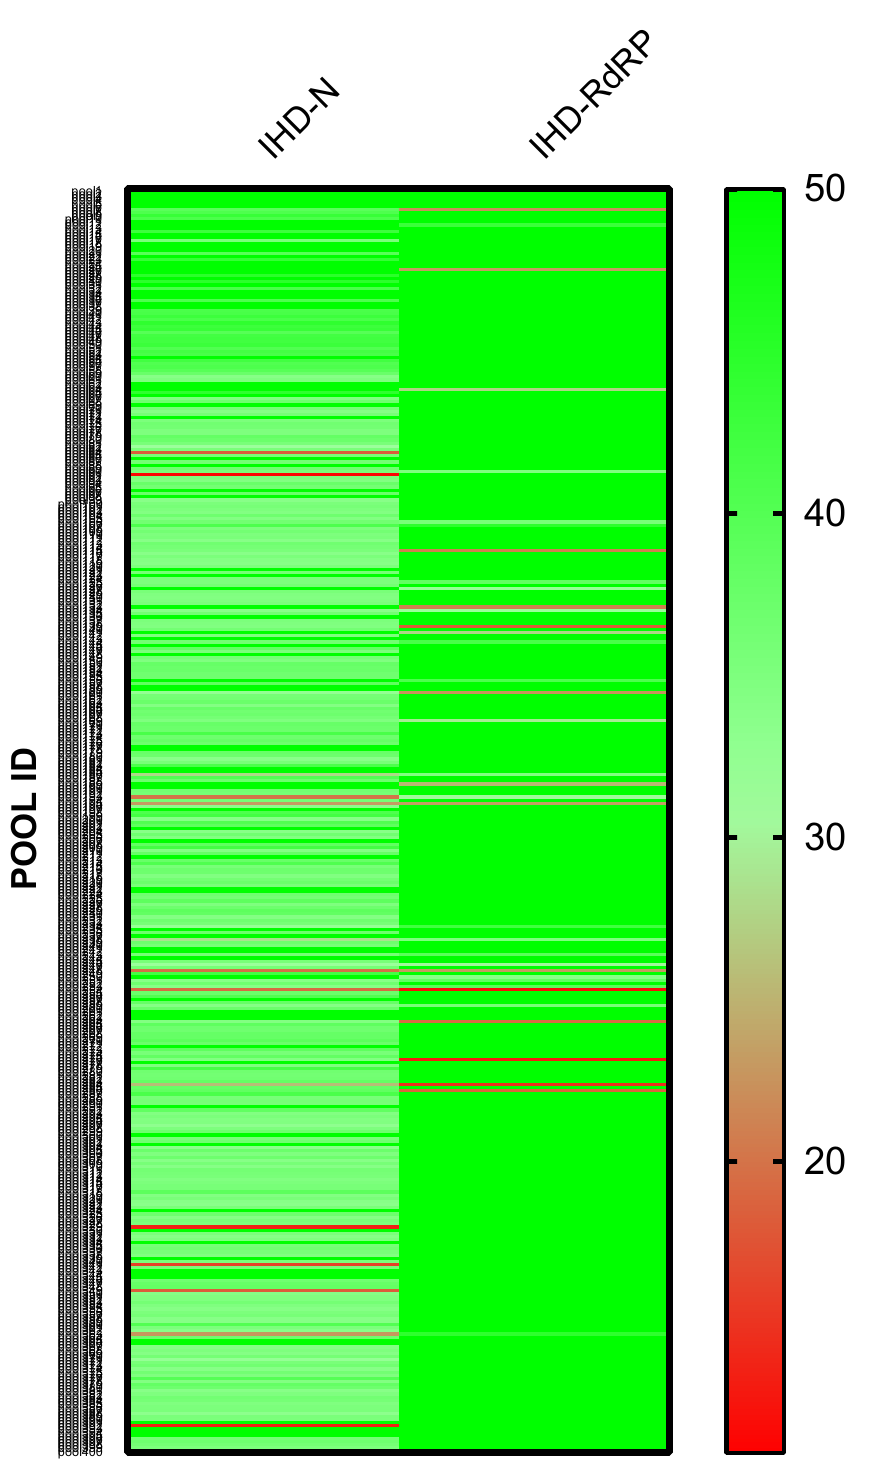
Figure 3. Heat map representing Ct values recorded by using an IHD multiplex assay for detection of SARS-CoV-2 N and RdRP genes on 400 pools obtained by grouping 1195 samples by three. Ct values of 50 were attribute to no amplified samples.